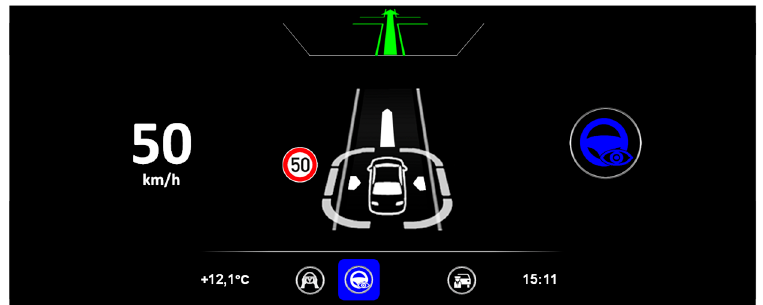
Figure 7 . Visualization of the instrument cluster , modified from Feierle et al. (2020) [41].